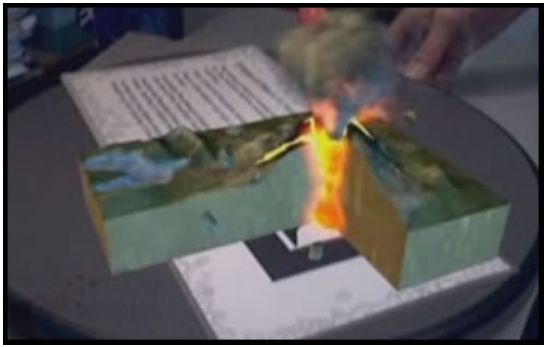
Fig. 1. Volcano on a Book is an example of an augmented book.